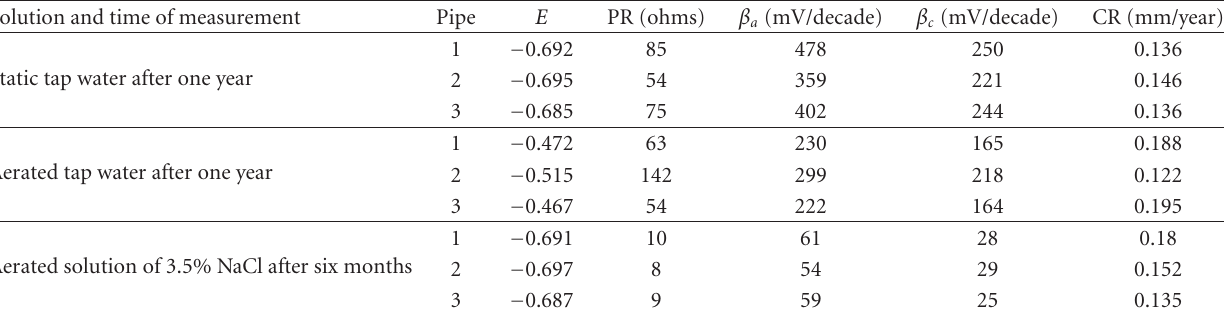
Figure 6: Corrosion products exposed in static tap water after (a) 1 month, (b) 2 months, (c) 5 months, and (d) 12 months. Table 4: Potentiostatic parameters and corrosion rate